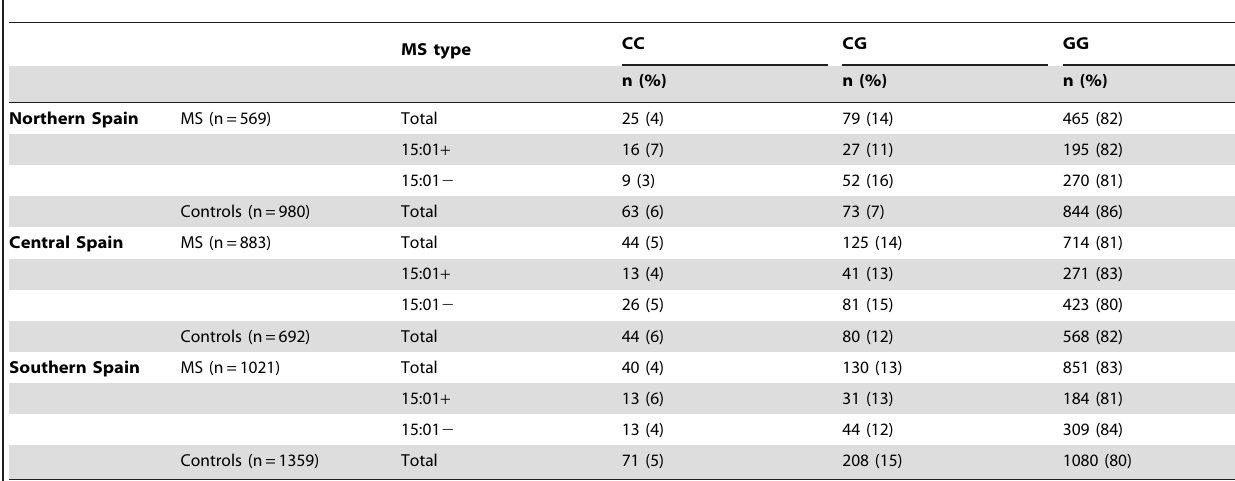
Table 2. Genotype frequencies of rs391745 in the Spanish cohorts included in the